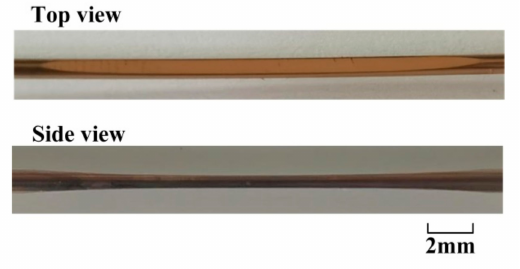
Figure 6. The photos of the double-sided polished fiber SPR probe.